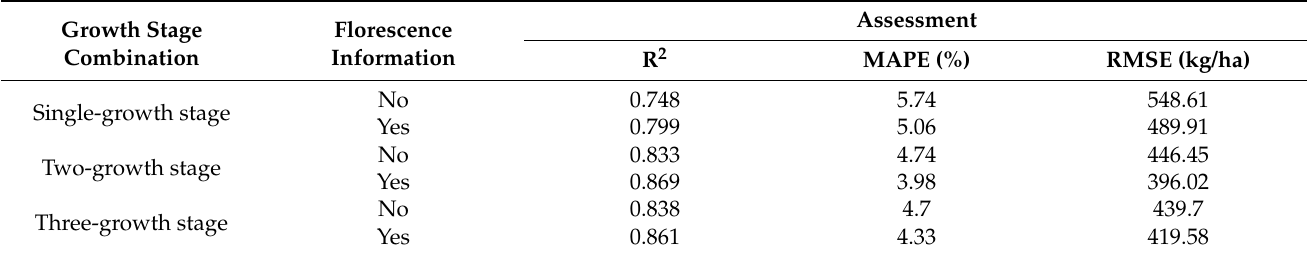
Table 6. Comparisons of the yield estimation models with and without considering florescence spectral information for the modeling dataset.